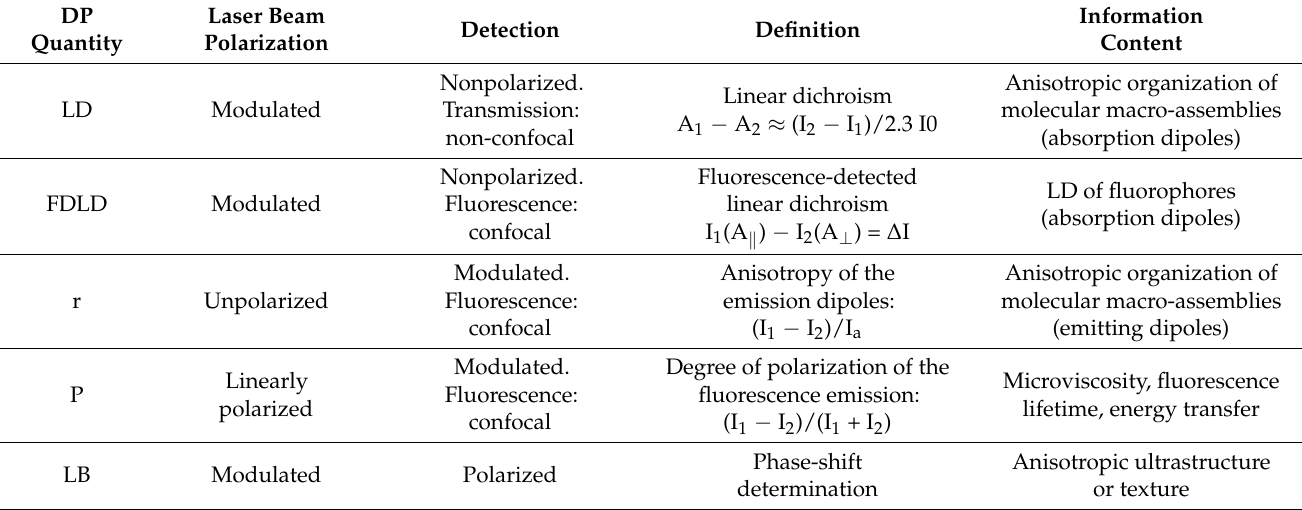
Table 1. Features of the main DP quantities which can be imaged in a confocal LSM via using linearly polarized light. For LD, FDLD, and r, I 1 and I 2 are the measured transmitted (LD) or fluorescence (FDLD, r) intensities with the requested polarization states with respect to a plane or axis, which is usually defined by the sample; for P, they are related to the plane of the polarization of the excitation beam; I 0 is the incident light intensity; A x is absorption, where x (=1, 2) refers to the appropriate polarization state. ∆ I and I a are the measured differential and average intensities, respectively. The term, “Modulated” refers to the modulation of the polarization state, between orthogonal states, of the excitation beam or the detected fluorescence emission. LB imaging requires the determination of the phase shift of a linearly polarized beam along a predetermined axis, see [29] and references